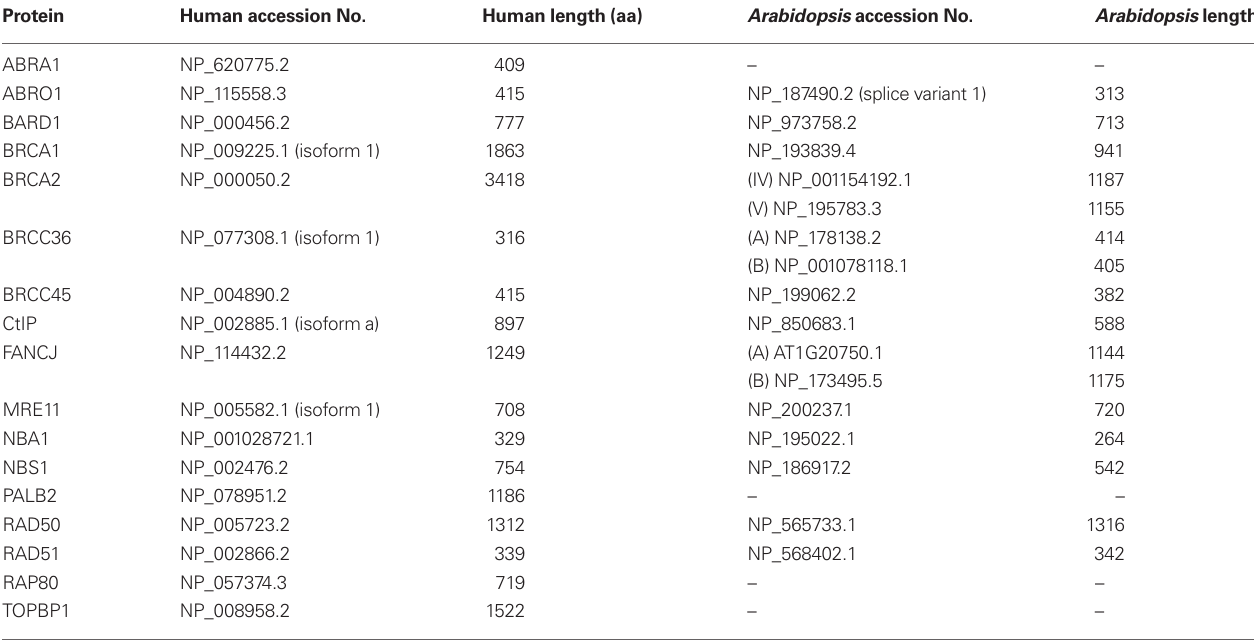
Table 1 | Proteins of the three human BRCA1 complexes, the BRiSC and their homologs in Arabidopsis . Protein Human accession